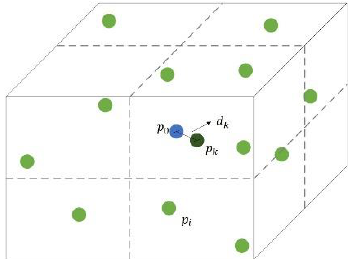
Figure 5. Schematic diagram of voxel retention points.